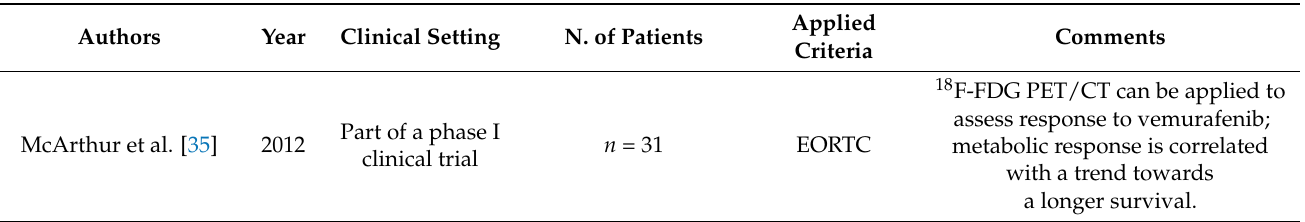
Figure 1. A 62-year-old male, previously submitted to excision of nodular cutaneous melanoma (Breslow thickness of 8 mm, Clark level IV, stage pT4a), performed 18 F-FDG PET/CT for staging before therapy. ( A ) MIP image showed areas of increased tracer incorporation in the left lung (black arrow) and adrenal gland (black bordered arrow). Molecular analysis was positive for BRAF V600e mutation and he started combination of BRAF and MEK inhibitors (dabrafenib plus trametinib). PET/CT MIP ( B ) performed after 3 months showed metabolic response to therapy. Fused corresponding PET/CT axial of the abdominal region ( C ) demonstrated almost complete regression of the non-homogenously hypermetabolic lesion in the left adrenal gland when baseline (upper row, arrow) is compared with follow-up PET/CT scan (lower row, arrow). Fused PET/CT axial of the lung ( D ) demonstrated regression of the hyperactive nodule in the left lung when baseline (upper row, arrow) is compared with follow-up scan (lower row, arrow). Table 2. Summary of main studies on 18 F-FDG PET/CT for response assessment to targeted therapy in BRAF-mutated